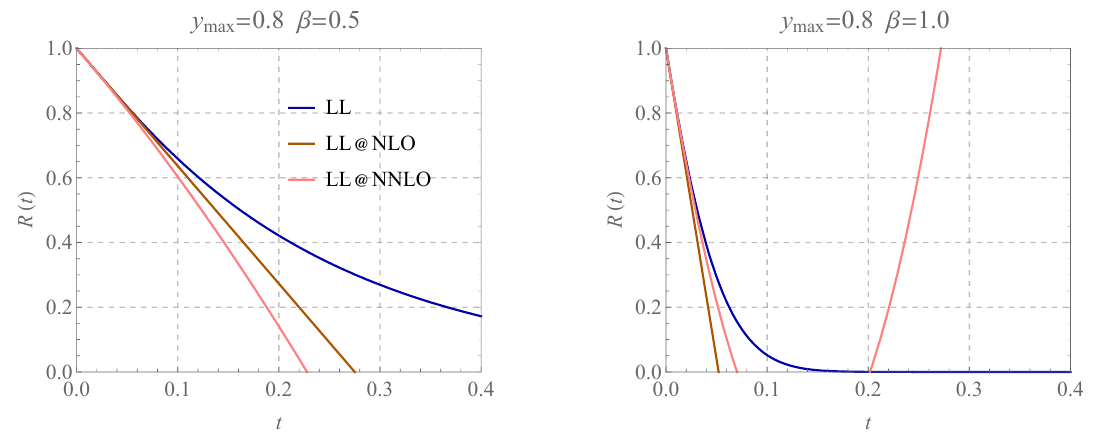
Figure 6 . Results of the LL resummation of the gap fraction from a dipole along the cone direction ~n . The left plot shows a massive dipole with (cid:12) = 0 : 5, the right one a massless one. The LL resummed result is shown in blue, (cid:12)xed-order expansions at NLO in brown and at NNLO in